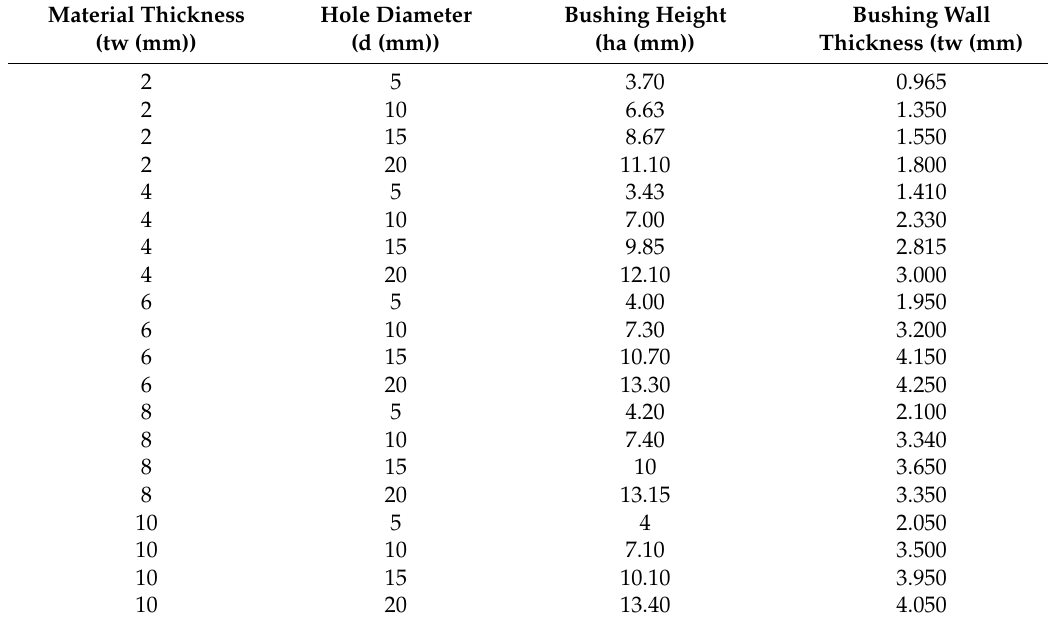
Table 1. The full factorial design of the selected parameters.